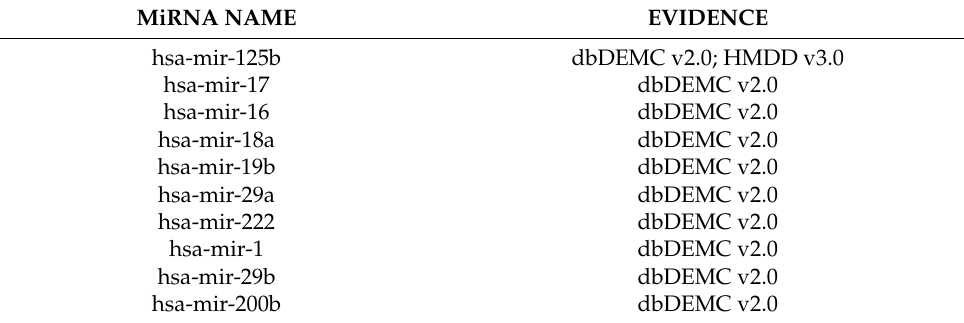
Table 7. Top 10 predicted miRNAs associated with esophageal